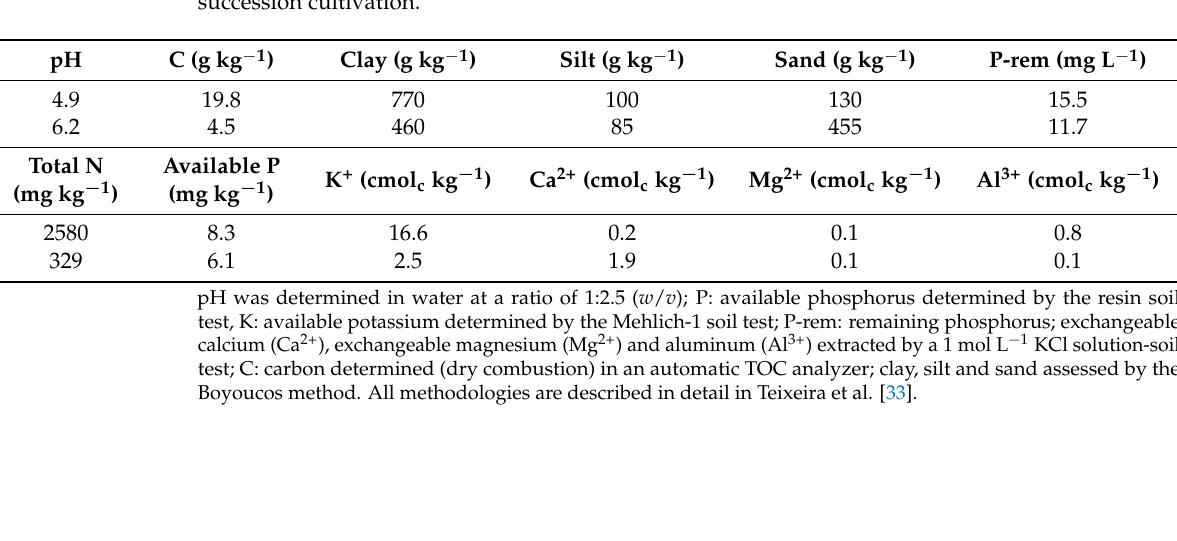
Table 2. Main chemical, physicochemical, and texture of Oxisols used in the maize–brachiaria grass succession